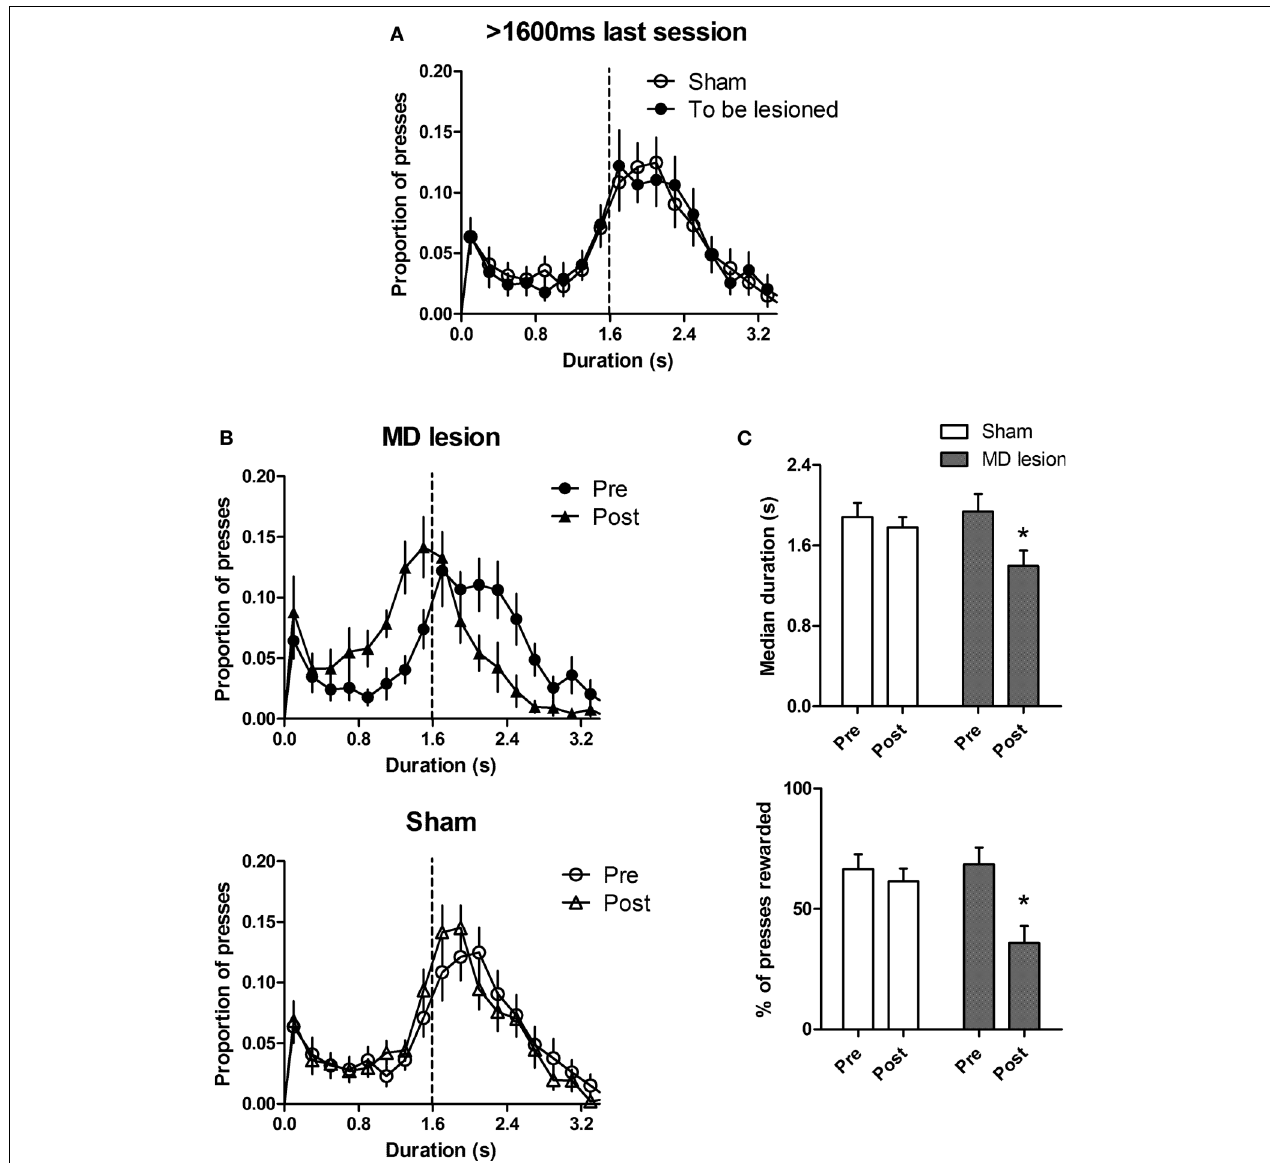
FIGURE 4 | Post-training lesion impairs temporal precision of lever pressing. (A) The distribution of press durations for sham ( n = 13) and to be lesioned ( n = 12) rats during the last session of 1600-ms training before surgery. (B) The distribution of durations for MD lesioned rats and sham